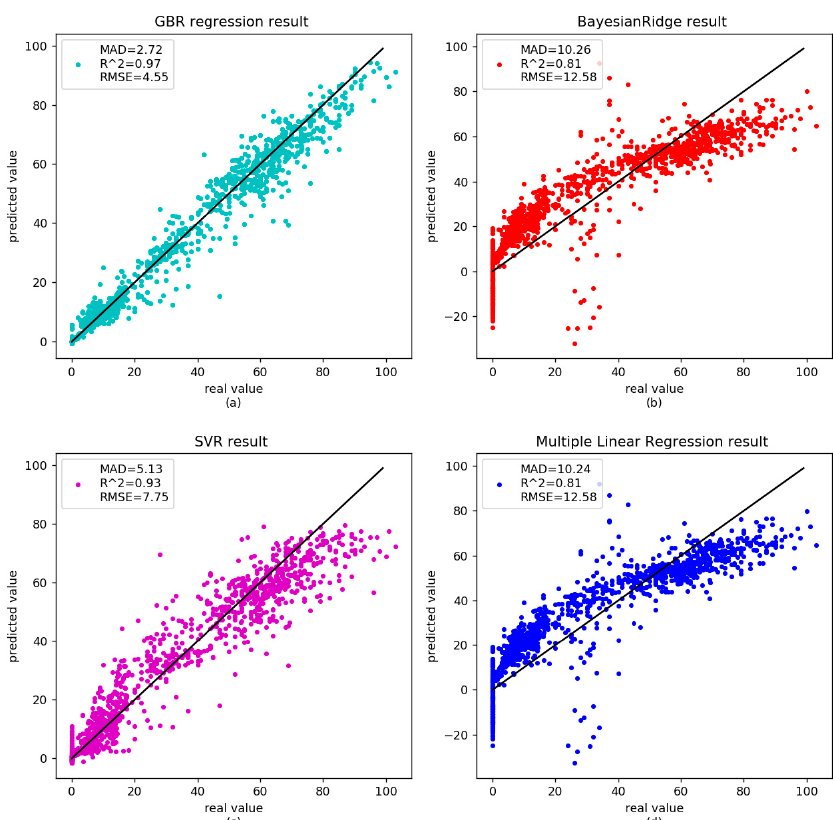
Figure 1. Comparison between the real age and the age predicted by the four models in the training dataset of health data. GBR: gradient boosting regresion; MAD: mean absolute deviation; RMSE: root mean square error; SVR: support vector regression. Table 4. Comparison of gradient booster regressor (GBR) with the other three methods on healthy datasets.